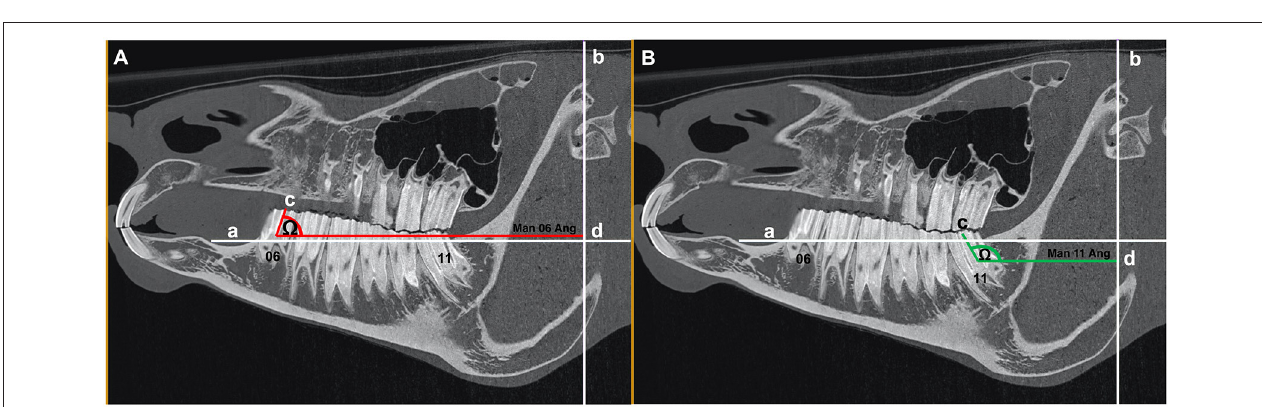
FIGURE 3 | (A) Sagittal CT image of an equine head showing line “a” that intersects the dorsal aspect of the mandibular bone immediately mesial to the mandibular second premolar (Triadan 06) tooth and the dorsal aspect of the mandibular bone immediately distal to the mandibular third molar (Triadan 11) tooth and line “b” at the level of the rostral aspect of the mandibular condyle that lies perpendicular to line “a.” The red line “c” drawn through the central long axis of mandibular Triadan 06 intersects line “d” that lies parallel to line “a” and perpendicular to line “b.” The angle ( (cid:127) ) created with the intersection of line “c” and line “d” was measured (Man 06 Ang). (B) Sagittal CT image of an equine head showing line “a” that intersects the dorsal aspect of the mandibular bone immediately mesial to the mandibular second premolar (Triadan 06) tooth and the dorsal aspect of the mandibular bone immediately distal to the mandibular third molar (Triadan 11) tooth and line “b” at the level of the rostral aspect of the mandibular condyle that lies perpendicular to line “a.” The green line “c” drawn through the central long axis of mandibular Triadan 11 intersects line “d” that lies parallel to line “a” and perpendicular to line “b.” The angle ( (cid:127) ) created with the intersection of line “c” and line “d” was measured (Man 11